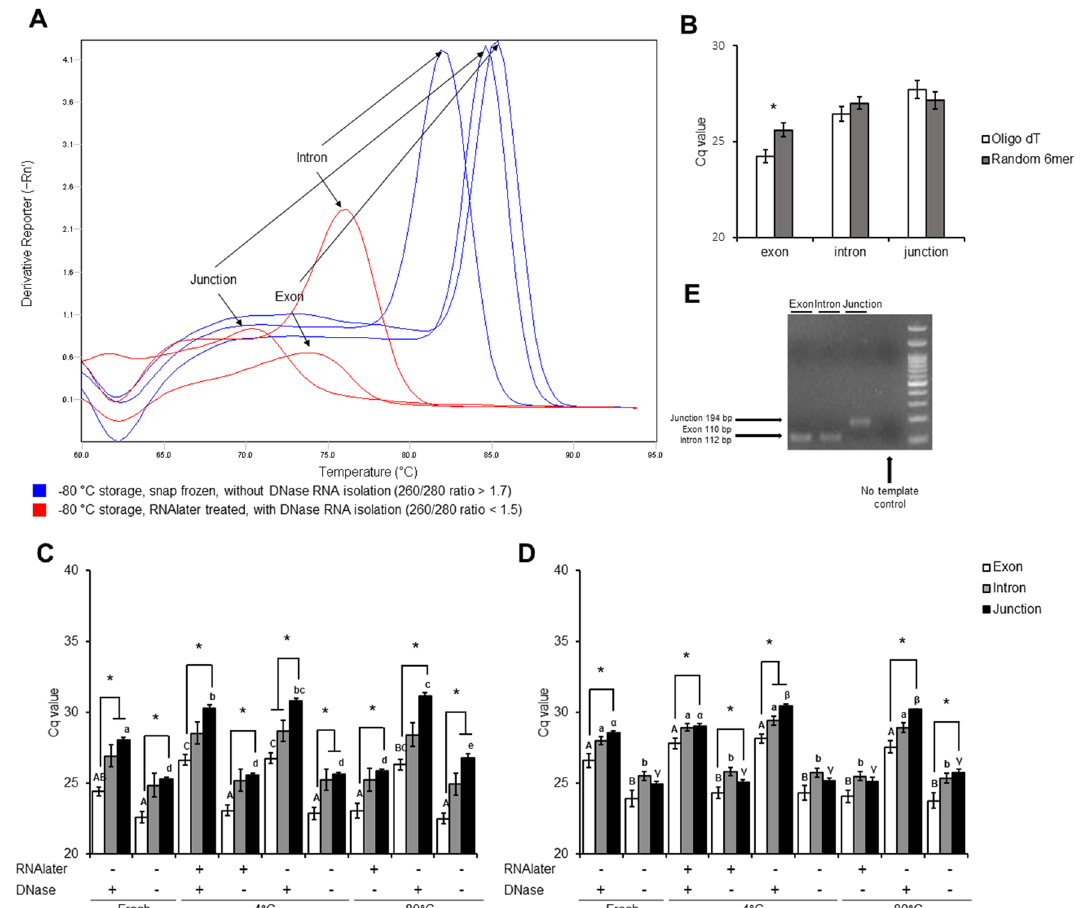
Figure 2. Effect of total sperm RNA processing method on RT-qPCR. ( A ) Melting curve of− 80 °C storage, snap-frozen, without DNase RNA isolation as a representative of normal RT-qPCR data from good quality RNA (260/280 ratio > 1.7) and− 80 °C storage, RNAlater-treated, with DNase RNA isolation as a representative of unnormal RT-qPCR data from bad quality RNA (260/280 ratio < 1.5). ( B ) Average Cq value of GAPDH exon, intron, and junction primers in synthesized cDNA with oligo dT and random hexamer primers. * P < 0.05 tested by Student’s t -test ( C ) Cq value of GAPDH exon, intron, and junction primers in synthesized cDNA with